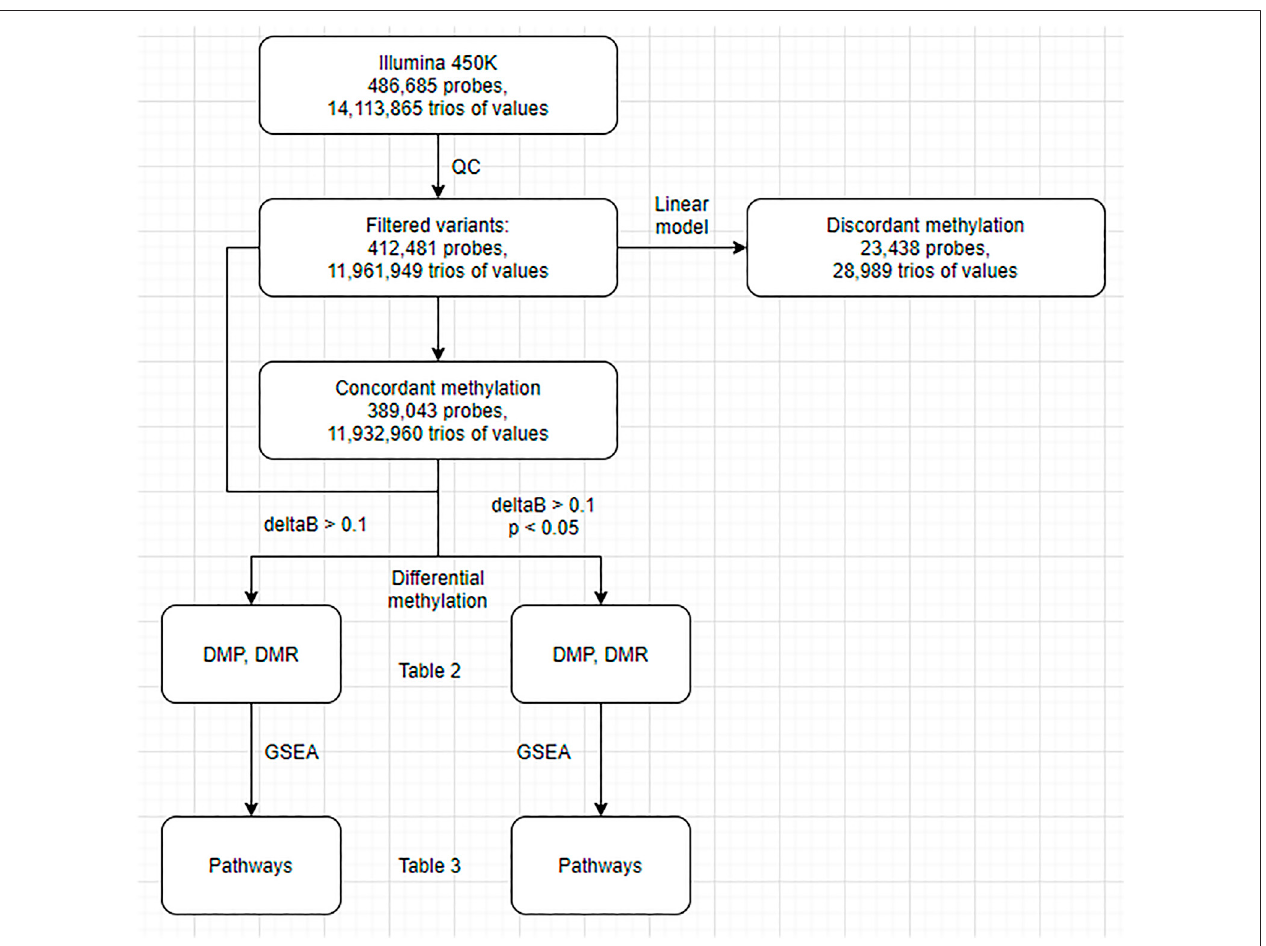
FIGURE 1 | Flowchart of the analysis. DMP, differentially methylated probes; DMR, differentially methylated regions; GSEA, gene set enrichment analysis.